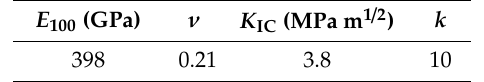
Table 1. Basic material parameters. k = 10 means the tensile strength is ten-times the compressive strength.